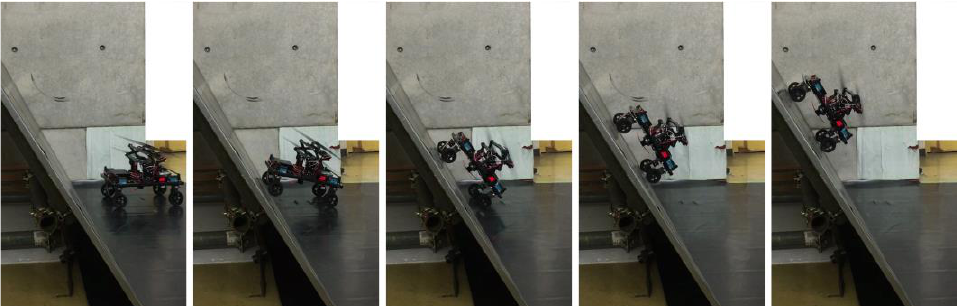
Figure 9. Transfer from a flat surface to a slope with an angle of 60°.